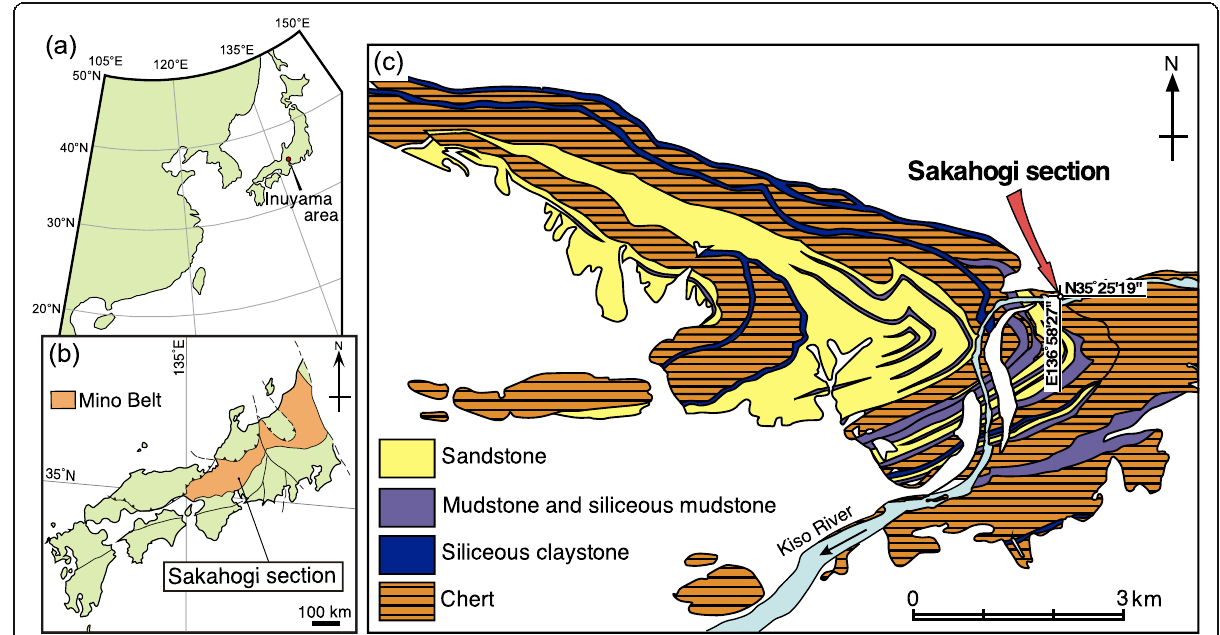
Fig. 1 Map showing the study area. a , b Geographic maps of the study area in the Inuyama area, Mino Belt, central Japan. c The Sakahogi section along the middle reaches of Kiso River